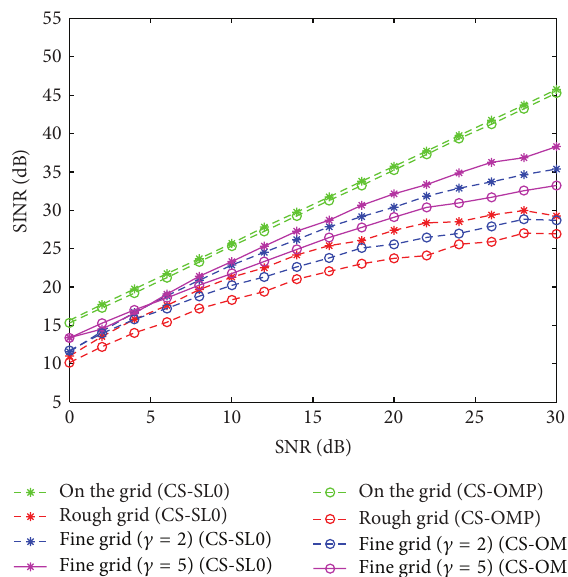
Figure 7: The output SINRs of the coarse and fine grids for CS-SL0 and CS-OMP.